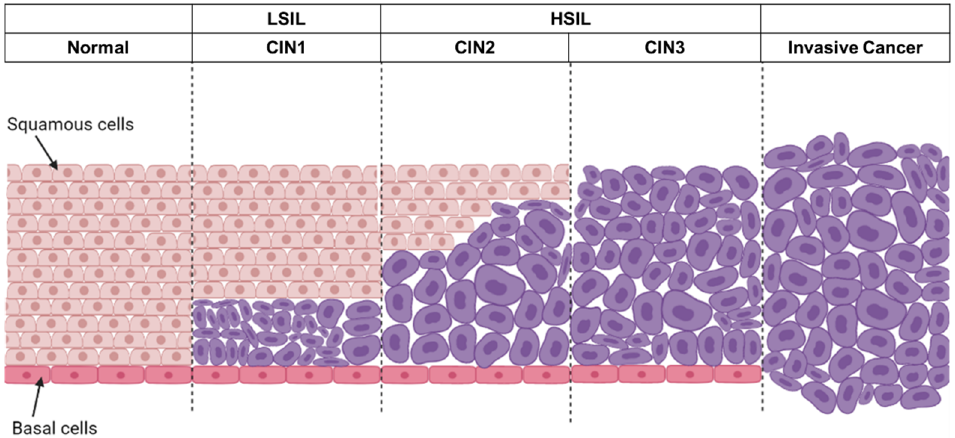
Figure 2. An overview of the progression of cervical cancer. Squamous cells are found in the outer part of the cervix, where a single layer of basal cells is attached to the basement membrane. Under persistent HR-HPV infection, cervical intraepithelial neoplasia may progress to invasive cancer. For cervical intraepithelial neoplasia 1 (CIN1) or low-grade squamous intraepithelial lesion (LSIL), dysplasia occurred in the lower 1/3 or less of the epithelium. CIN2/3, also called high-grade squamous intraepithelial lesion (HSIL), had significantly more dysplasia.